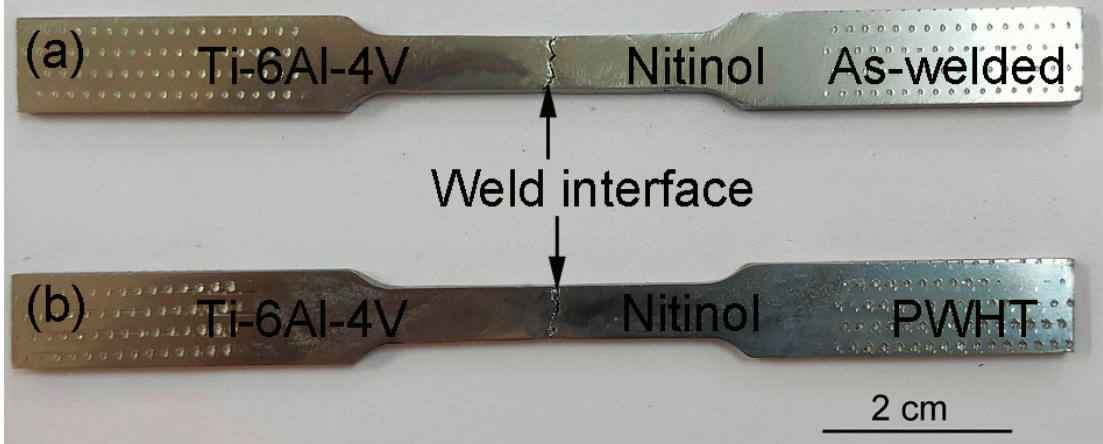
Figure 12. The failure location of the dissimilar Ti-6Al-4V/Nitinol joints in the ( a ) as-welded and ( b ) PWHT conditions.